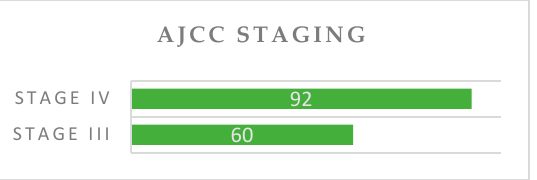
Figure 5. Tumor localization staging.